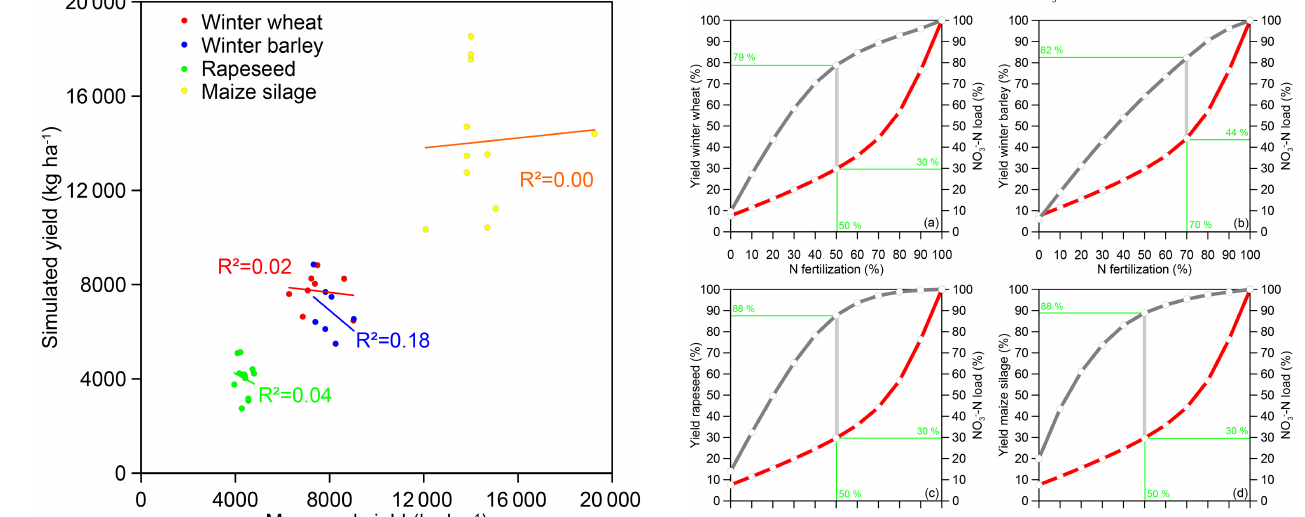
Table 4. Daily model performances with regard to streamflow and NO − (2010–2015). NSE Nash-Sutcliffe Efficiency, PBIAS Percentage bias.